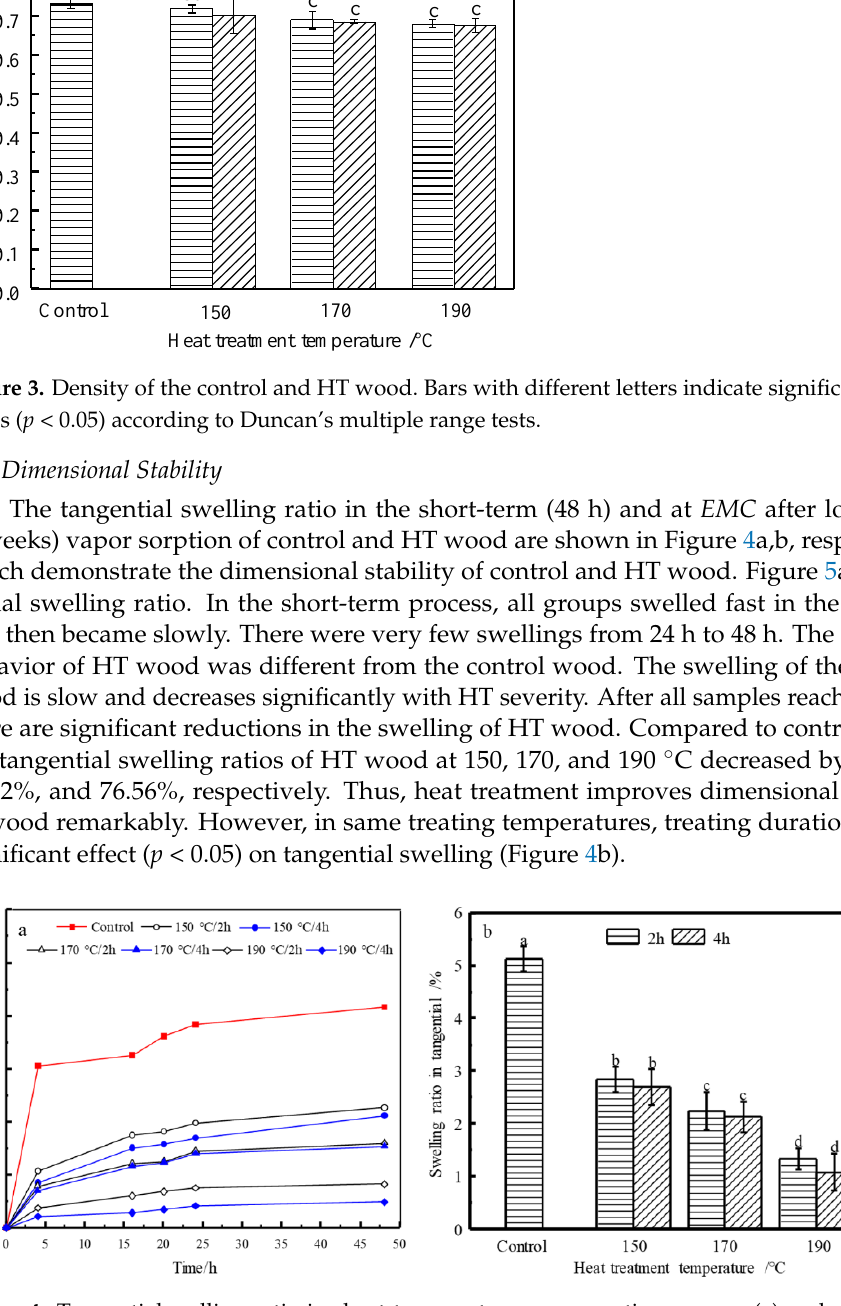
Figure 4. Tangential welling ratio in short-term water vapor sorption process ( a ) and at EMC of the control and HT wood ( b ). Bars with different letters indicate significant differences ( p < 0.05) according to Duncan’s multiple range tests.